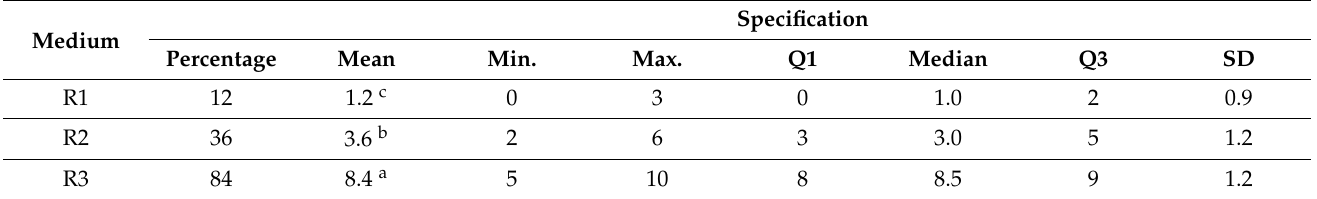
Table 2. Descriptive statistics (percentage, mean, maximum, minimum, –1—the first quartile, median, Q3—the third quartile, SD standard deviation) of the rooted plants in each medium.